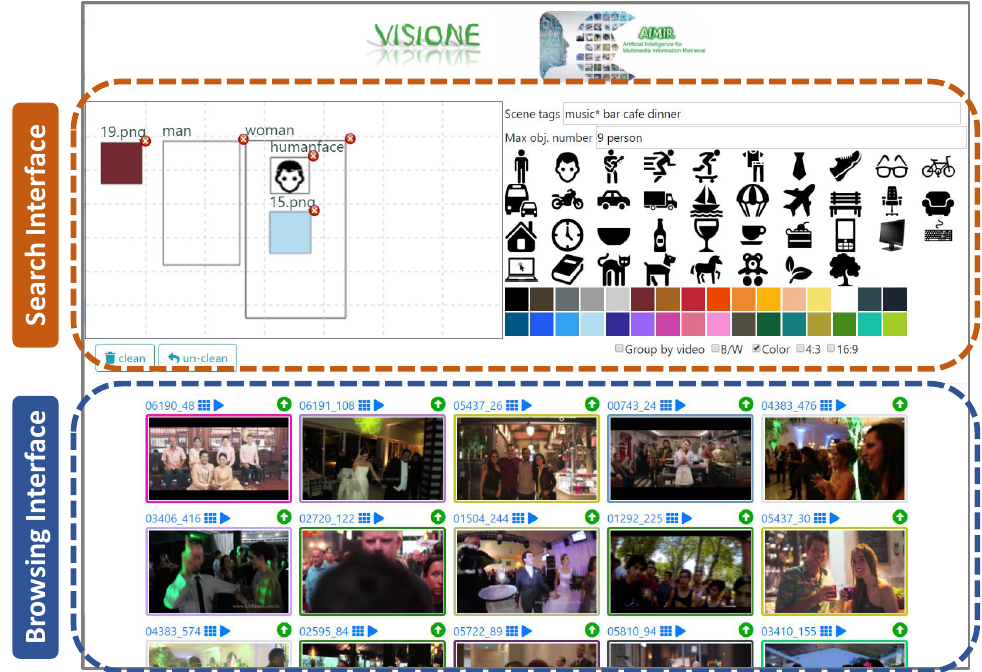
Figure 2. A screenshot of the VISIONE User Interface composed of two parts: the search and the